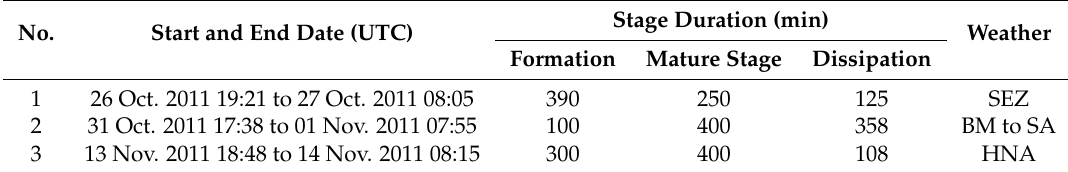
Table 1. Investigated fog events (see the text for detailed